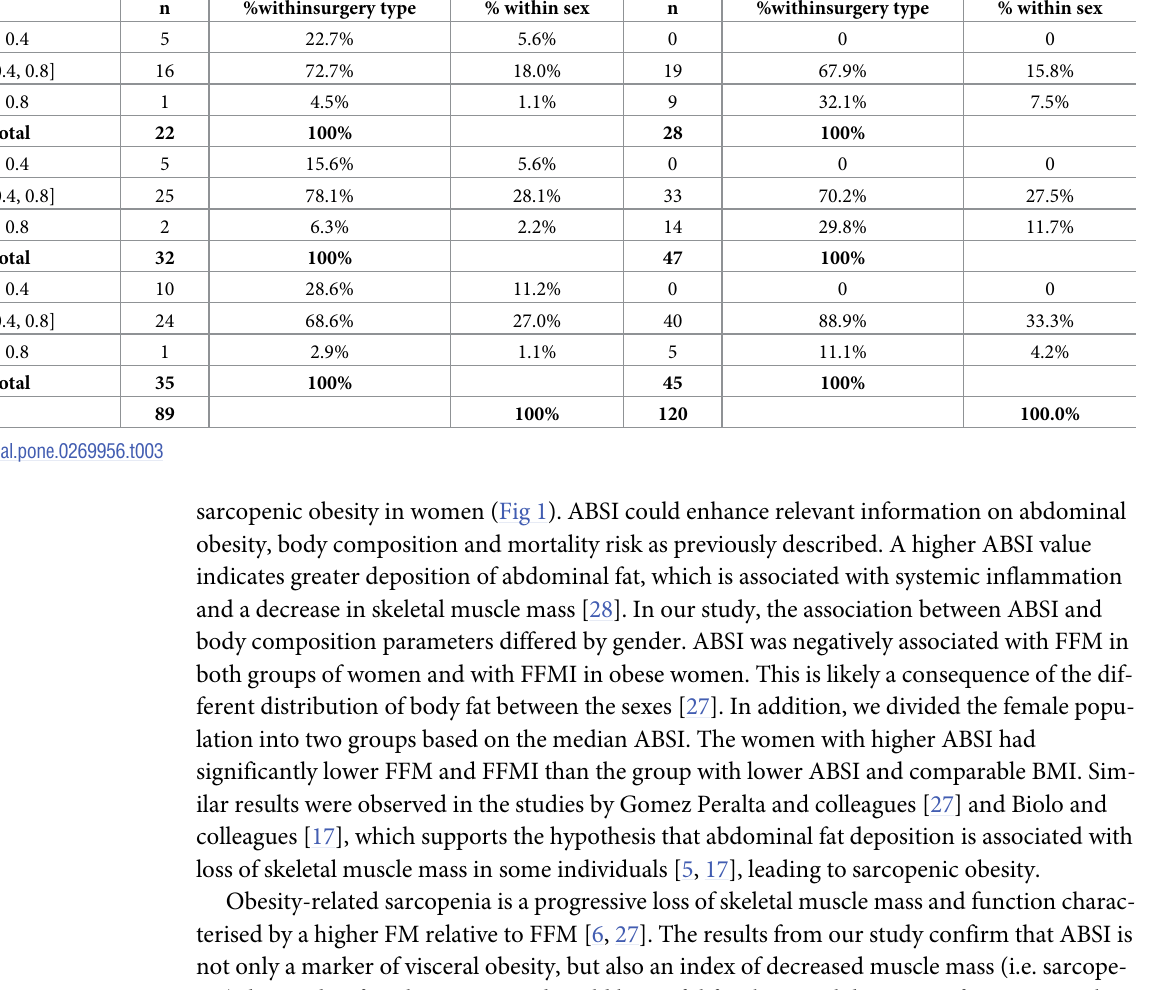
Table 3. Prevalence of sarcopenic obesity among patients undergoing orthopaedic surgery. Type of